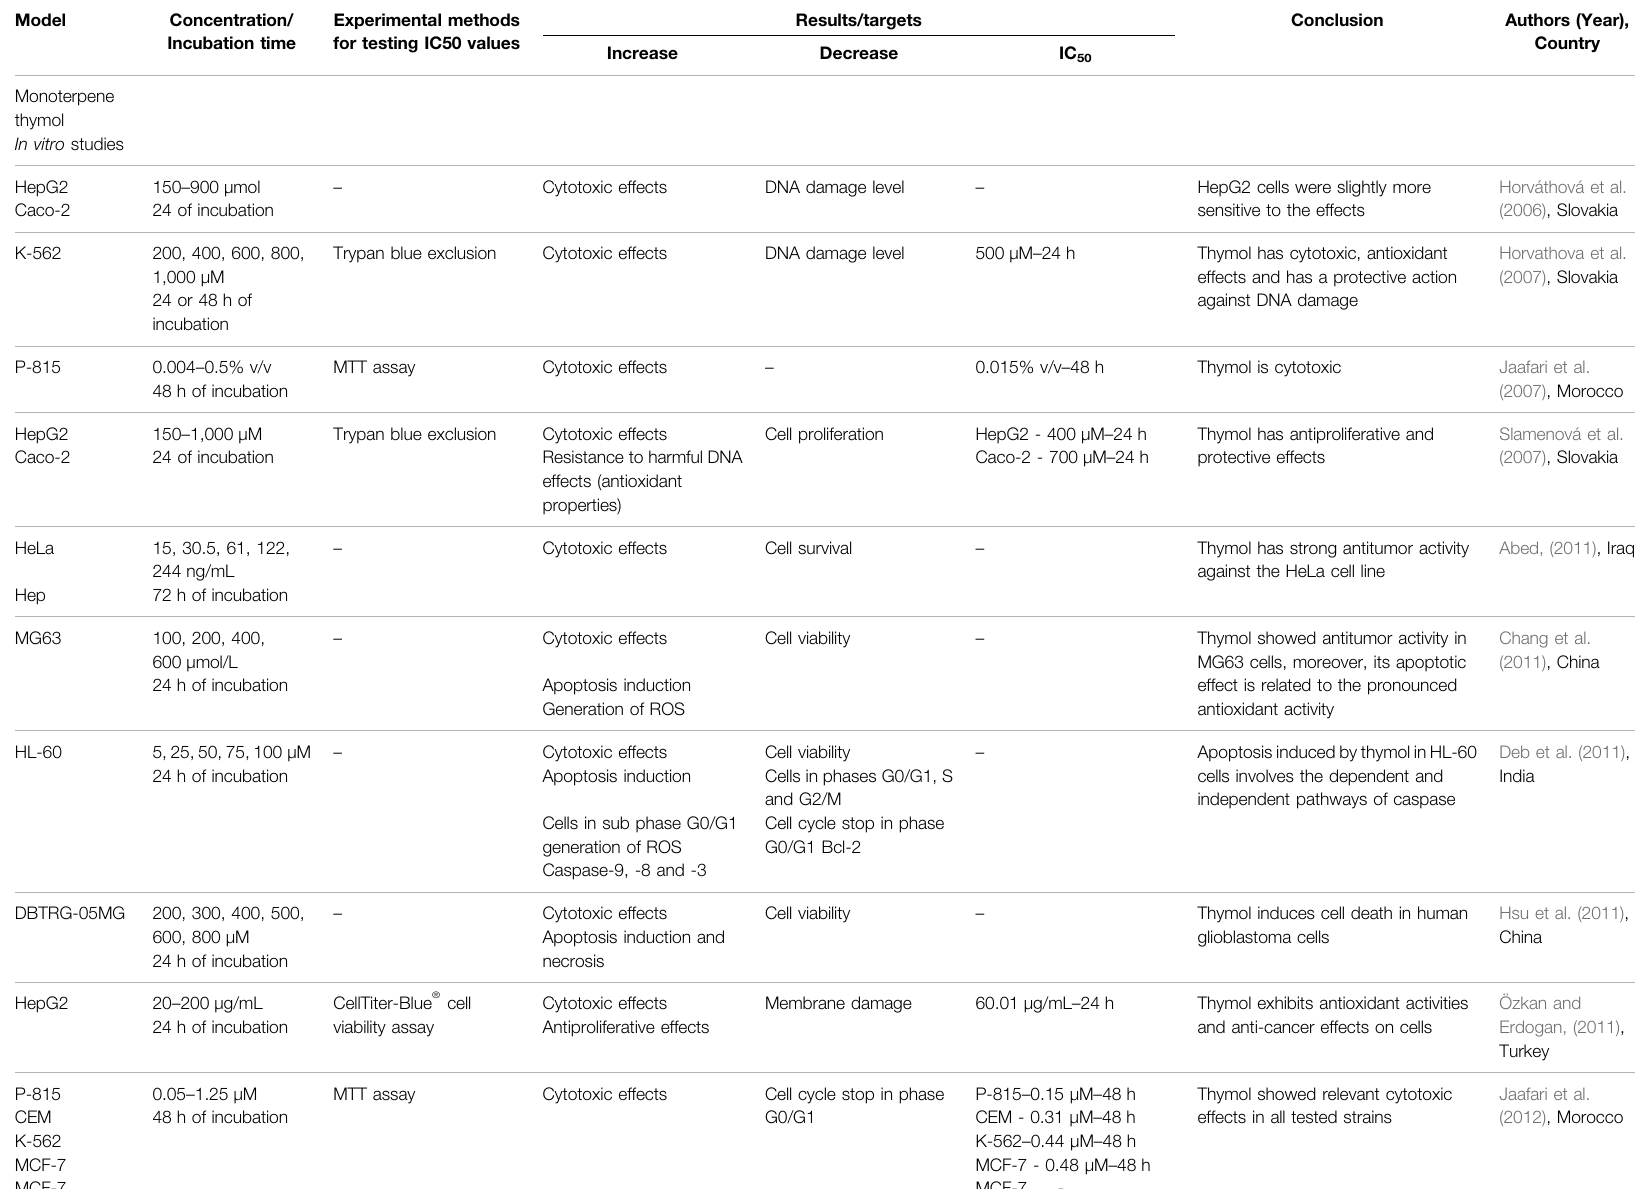
TABLE 2 | Detailed description of the studies that used thymol, included in the systematic